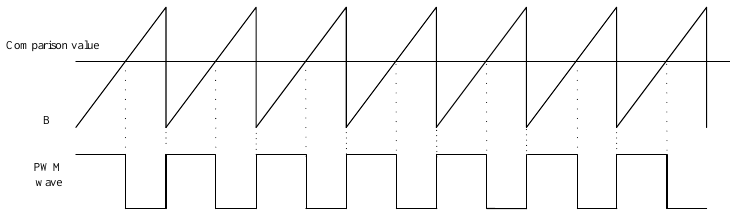
Figure 18. PWM signal waveform